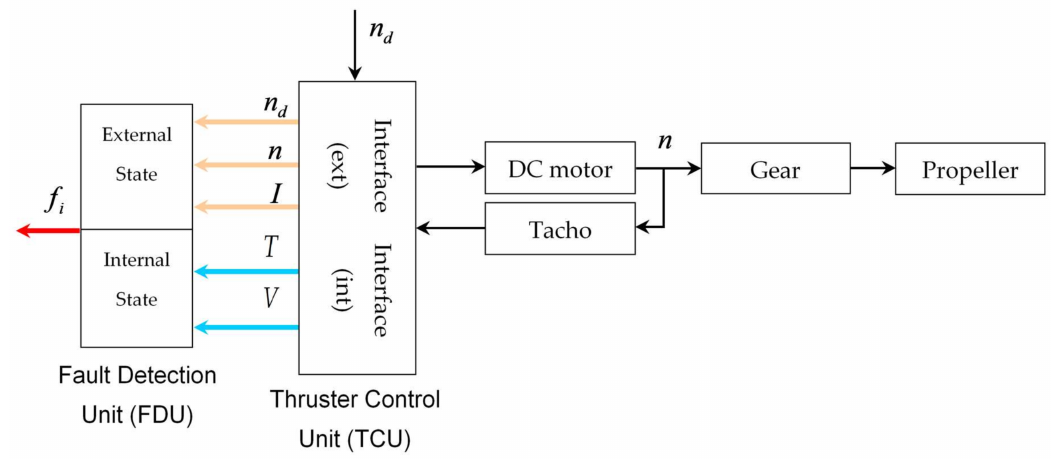
Figure 3. Block diagram showing connections between the fault detection unit (FDU) and the thruster control unit (TCU) for thruster T i